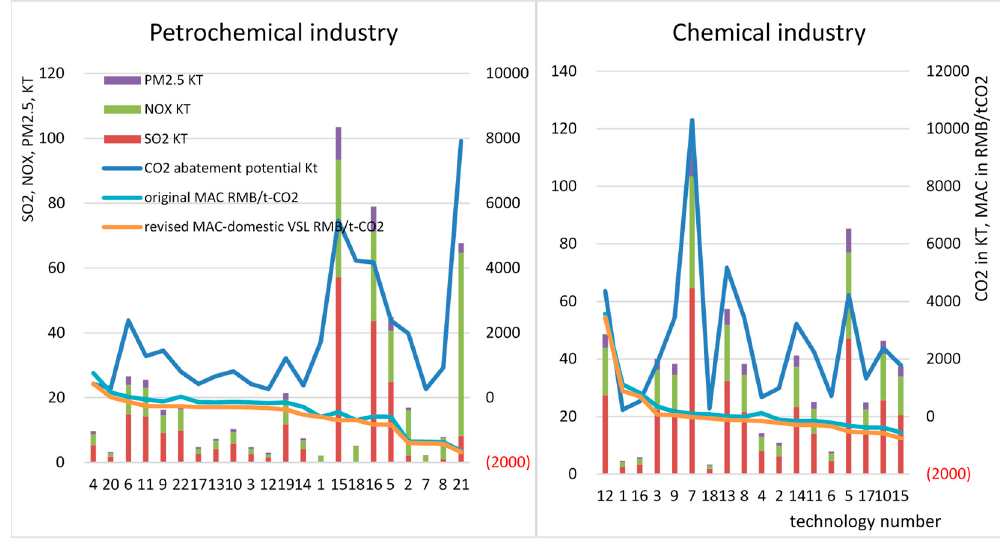
Figure 12. Technical sequencing of technologies.